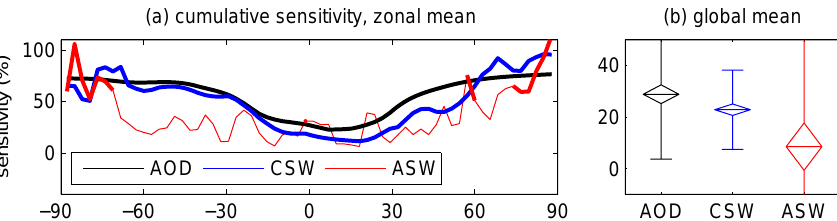
Fig. 7. Percent sensitivity to eruption season for cumulative anomalies of AOD (black), clear-sky surface shortwave radiation (blue) and all-sky surface shortwave radiation (red), calculated as difference between maximum and minimum response (black lines in Fig. 5) divided by minimum response. Zonal mean quantities plotted versus latitude to left (a) , global mean quantities plotted in contracted y-scale to right (b) . Thick lines in panel a show where response is significant at the 95% level. In panel (b) , horizontal lines within diamonds indicates ensemble mean, vertical range of diamonds indicates standard error of mean, and vertical error bars indicate 2 σ ensemble variability.